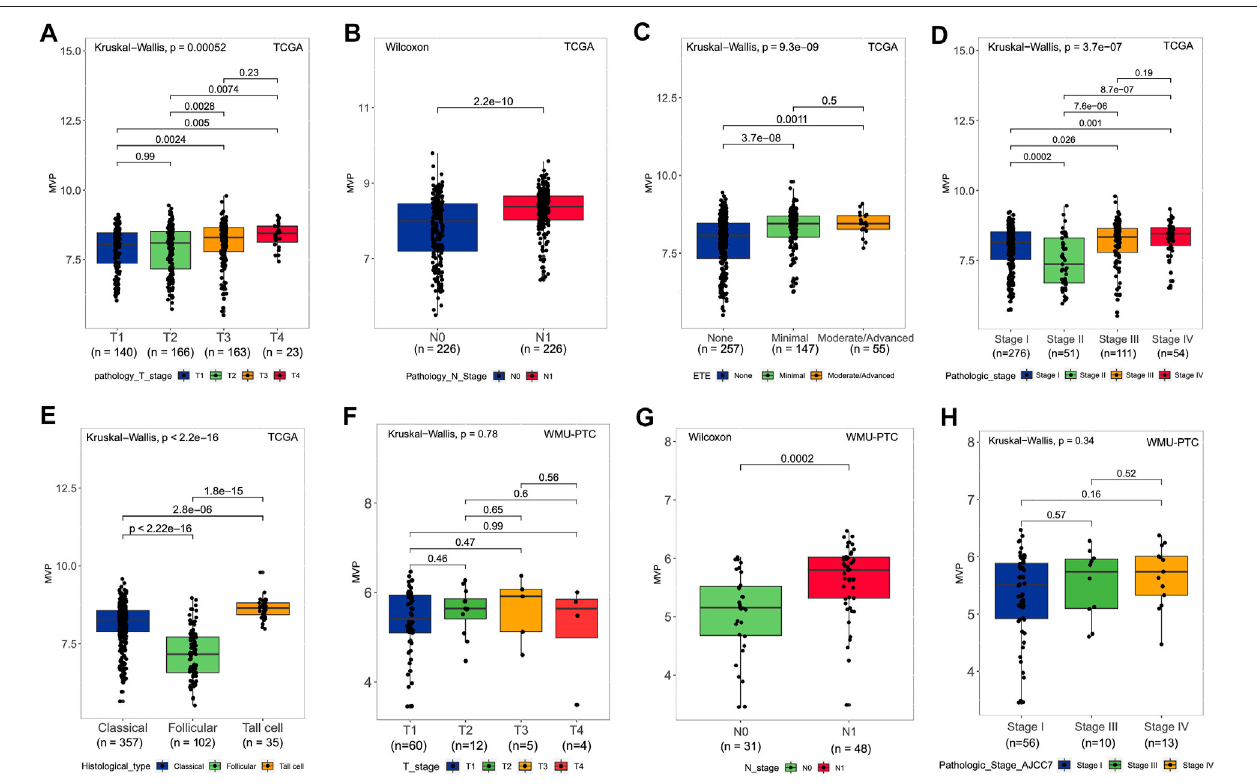
FIGURE 2 | MVP level and relationship with clinical and pathological features of PTC patients. (A-E) For the TCGA cohort, the MVP level in distinct (A) T stage, (B) lymph node status, (C) extrathyroidal extension, (D) pathologic stage, and (E) histological subtypes. (F-H) For WMU-PTC dataset, MVP level in distinct (F) T stage, (G) lymph node status, and (H) pathologic